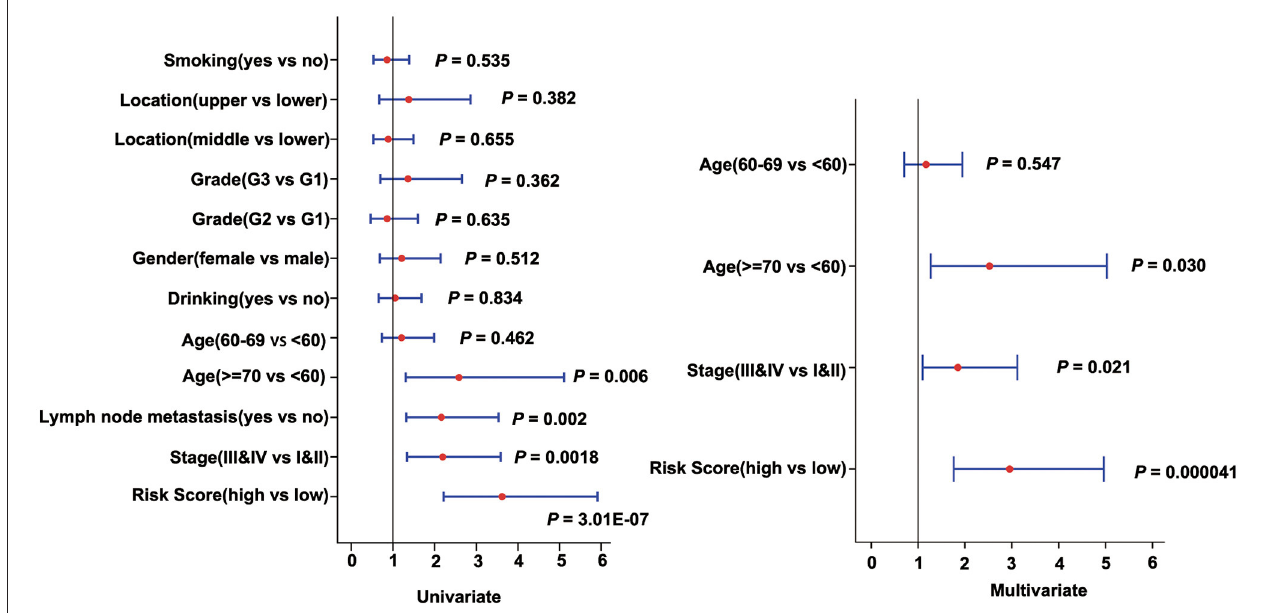
FIGURE 6 | Forest plot of univariate and multivariate Cox regression analyses in the discovery cohort (GSE53624).